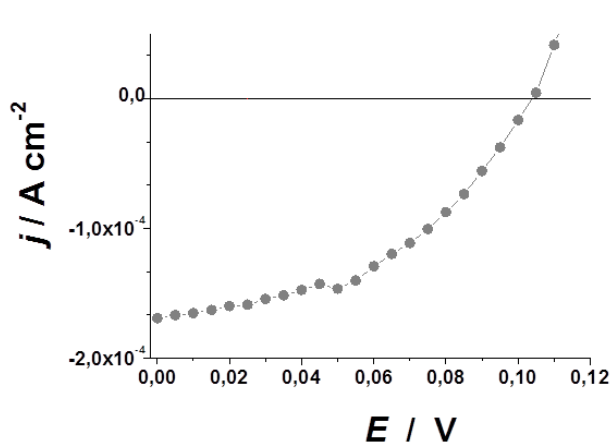
Figure 5. jV characteristic curve of the p ‐ DSC utilizing bare NiO photocathode, i.e. , a sensitizer ‐ free photoactive electrode. Electrolyte: HSE from Dyesol. Incident light intensity: 1000 W ∙ m − 2 . The radiation source is sun simulator with AM 1.5G. The electroactive area of the photoelectrode is 5 × 5 mm 2 . Adapted from reference [13].